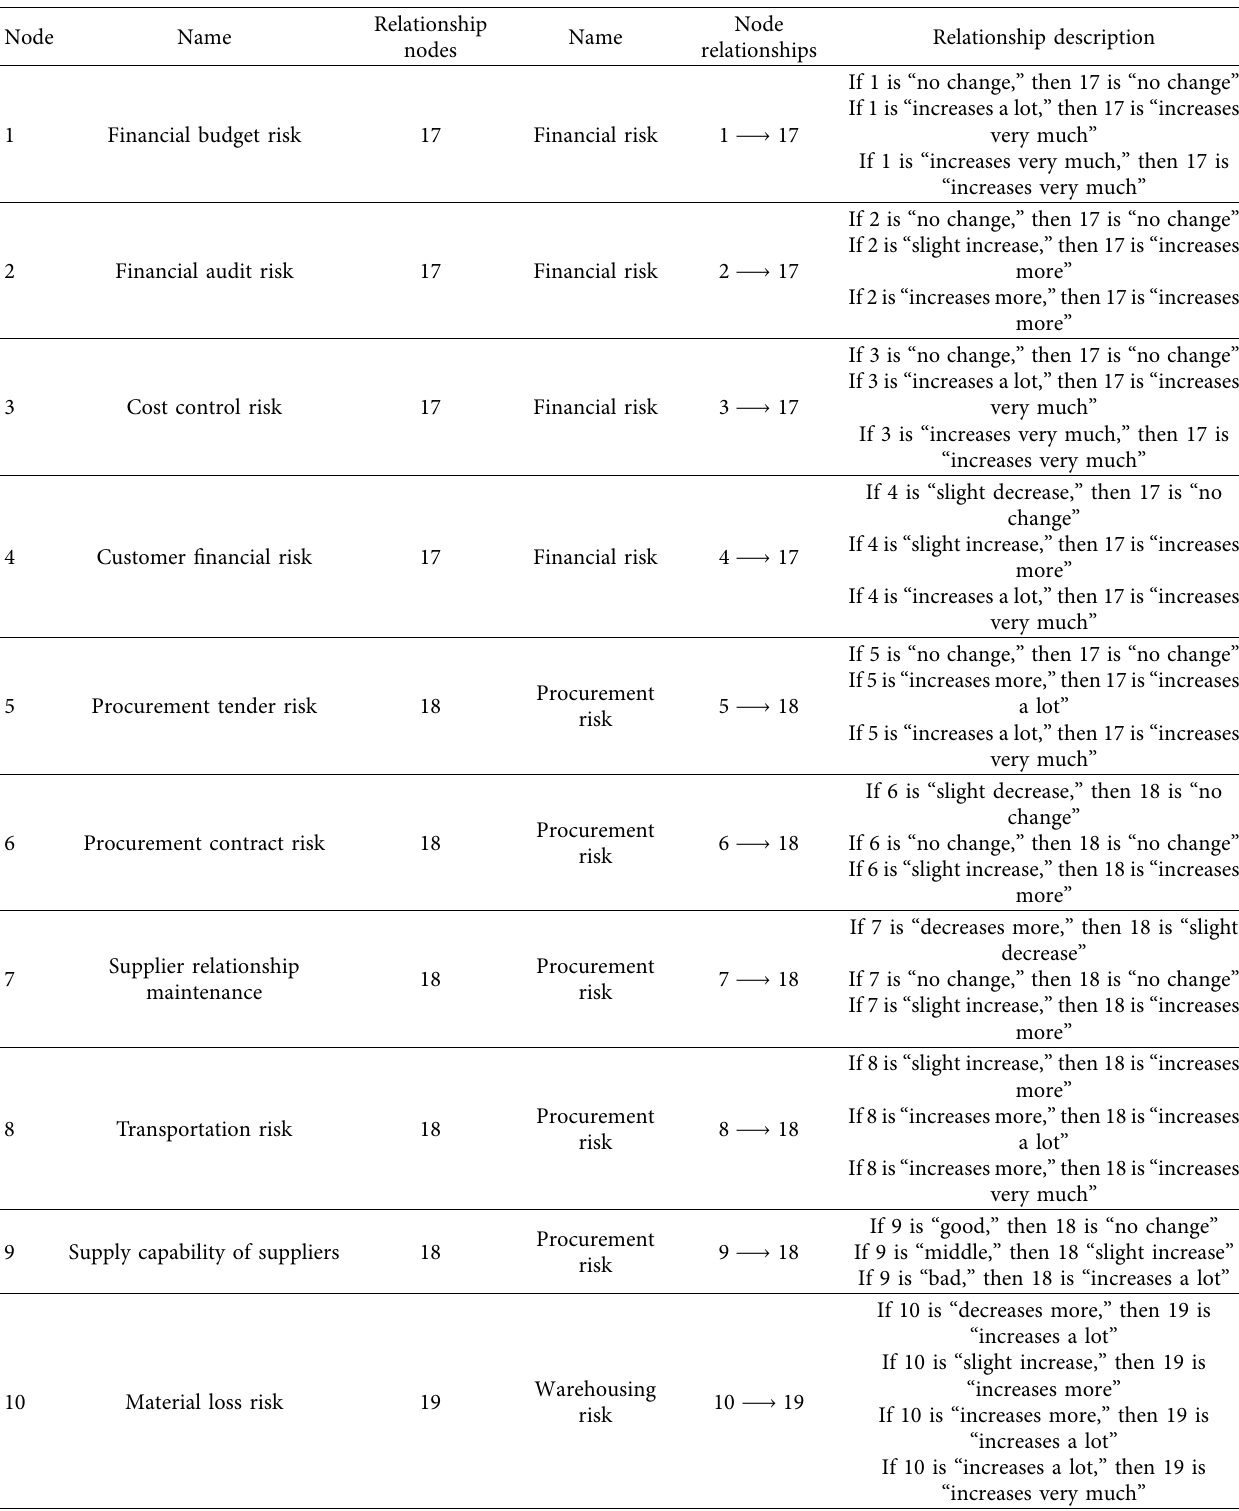
Table 2: Fuzzy relationship of risk